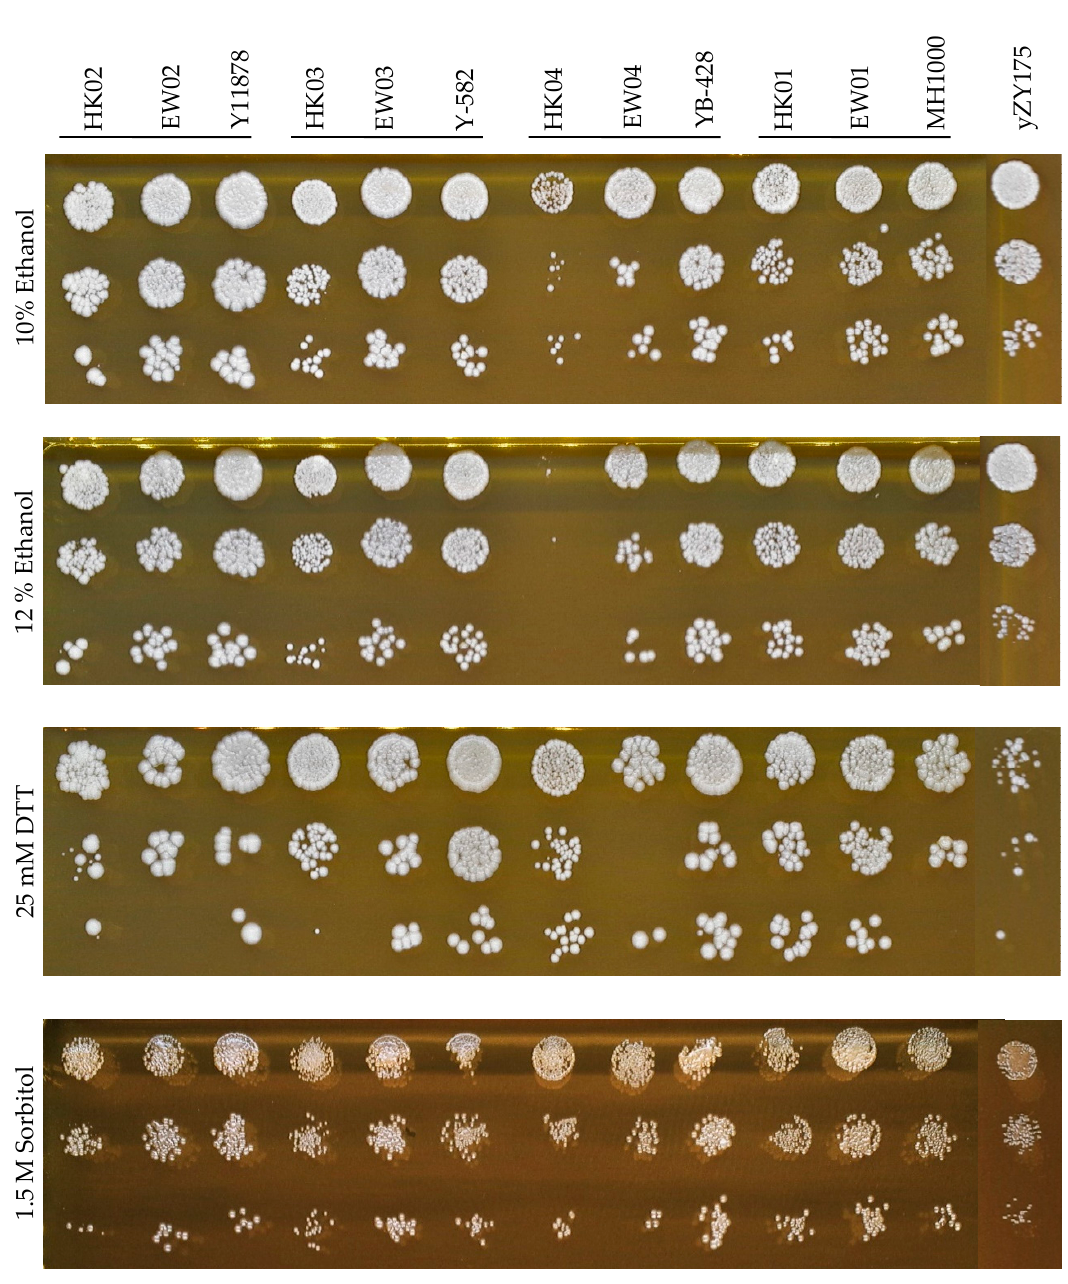
Figure 3. Fitness assays of generated heterologous diploid strains EW01-04, their parental haploids (HK01–04 and yZY175) and the corresponding diploid strains (industrial diploids). Spot assays were performed on YPD containing 10–12% ( v / v ) ethanol, 25 mM dithiothreitol (DTT) and 1.5 M sorbitol incubated for 72h.